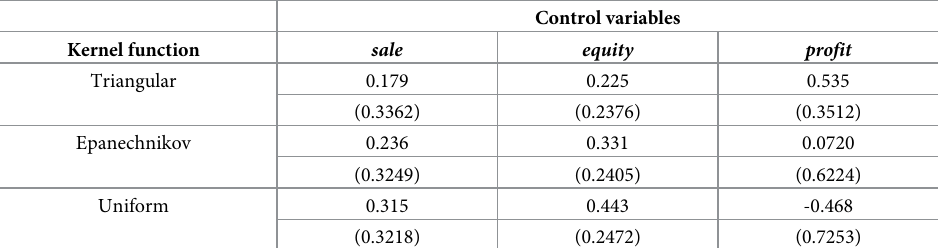
Table 4. Continuity test of control